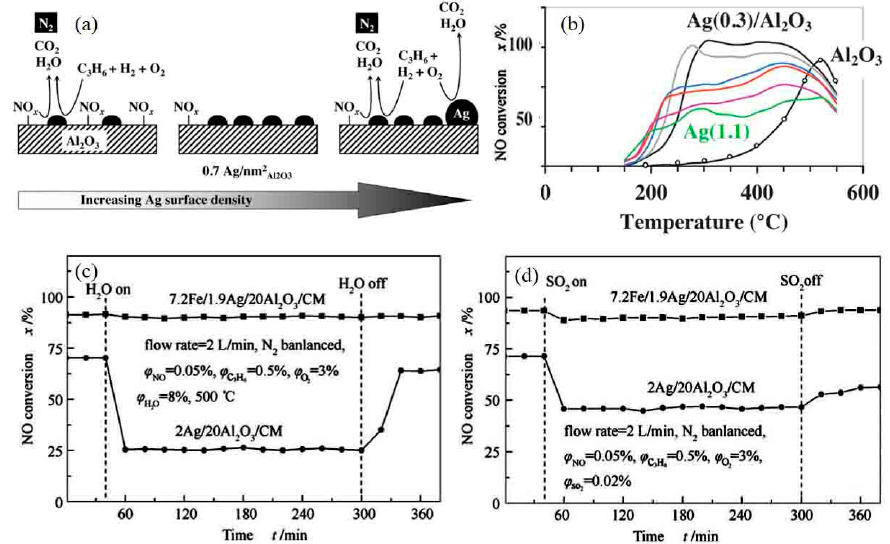
Figure 13. ( a ) The mechanism of C 3 H 6 selective catalytic NO removal on Ag / Al 2 O 3 surface, ( b ) the e ff ect of Ag loading on NO conversion [205], and ( c , d ) the e ff ect of Fe doping on the sulfur resistance and water resistance of Ag / Al 2 O 3 catalyst [206]. Reproduced from Ref. [206], Copyright 2017,